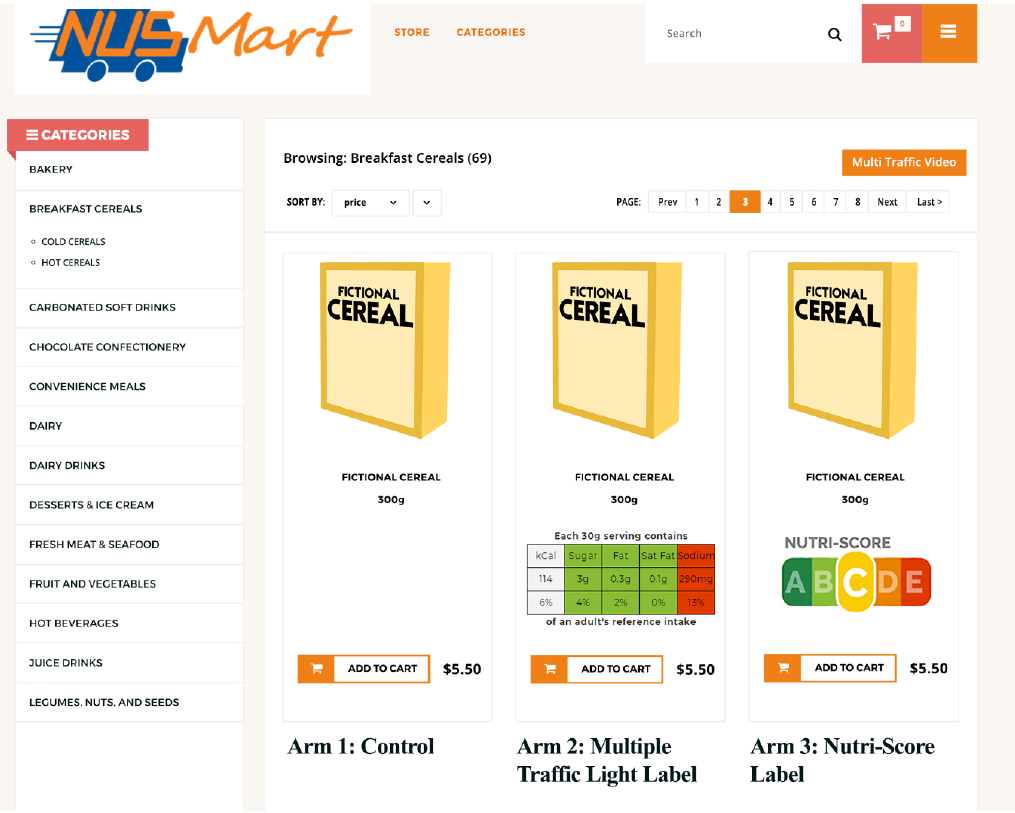
Figure 2. Example of the storefront with a sample of the Multiple Tra ffi c Light and Nutri-Score labels on the same product as it appears in each